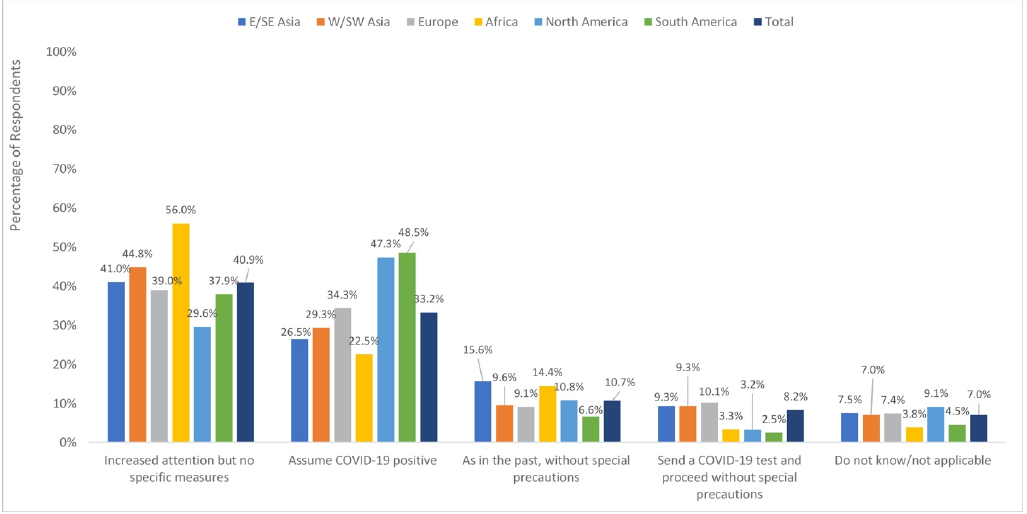
Figure 2. Approach to the management of emergency cases requiring immediate surgery by Figure 2 . Approach to the management of emergency cases requiring immediate surgery by region .